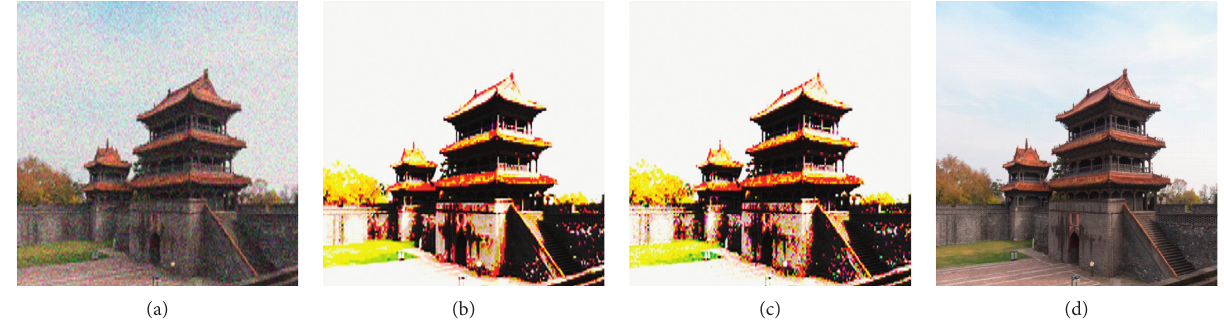
Figure 3: Comparison of restoration effects of cultural heritage buildings: (a) Haar wavelet 2-level decomposition PSNR � 39 dB, (b) Bior4.4 wavelet 2-level decomposition PSNR � 41 dB, (c) Haar wavelet 4-level decomposition PSNR � 39dB, and (d) Bior4.4 wavelet 4-level decomposition PSNR � 41 dB.